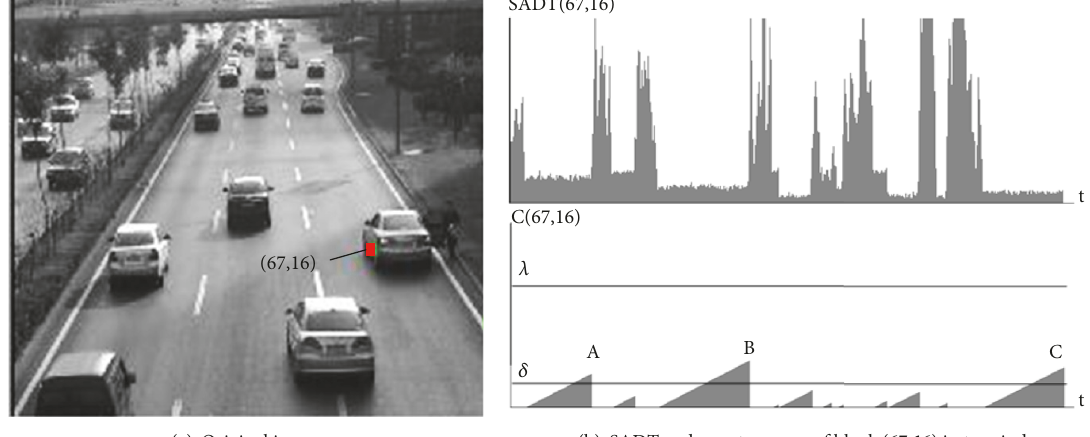
Figure 17: Effect of passing vehicles on detection.